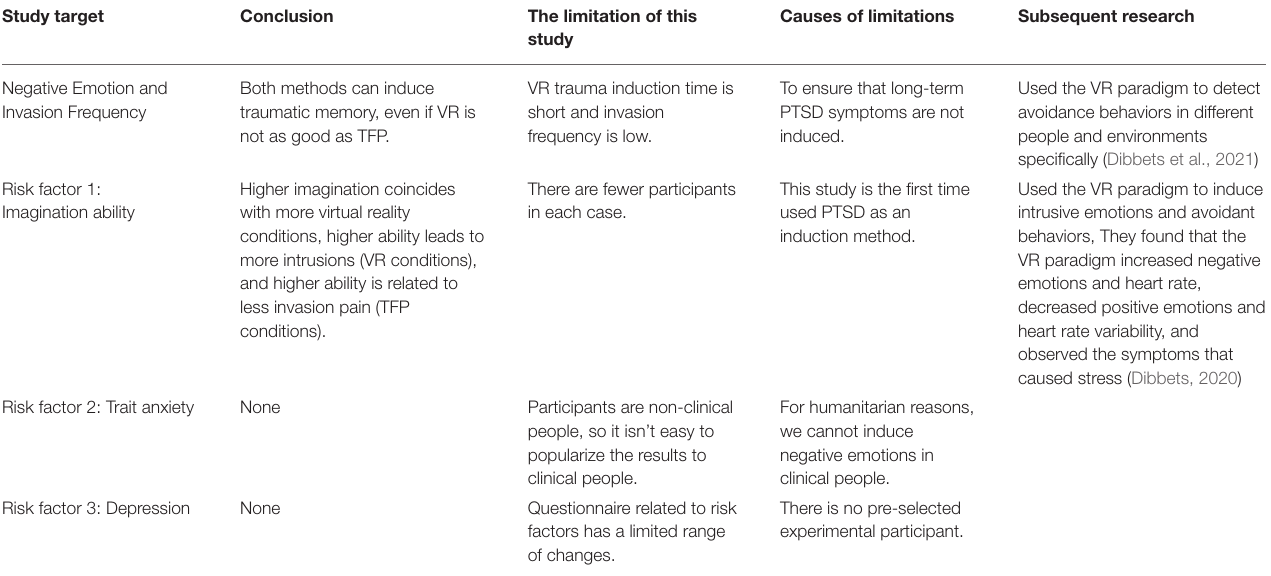
TABLE 1 | Comparison of research